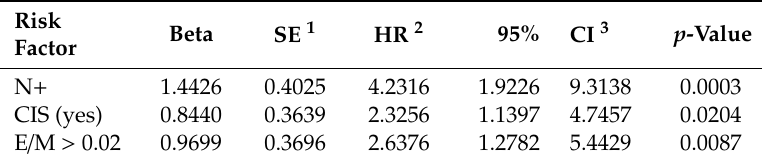
Table 2. Cox regression model for disease-free survival. The model includes the most contributive clinicopathological variables (see Appendix A Table A1) and the binarized E / M